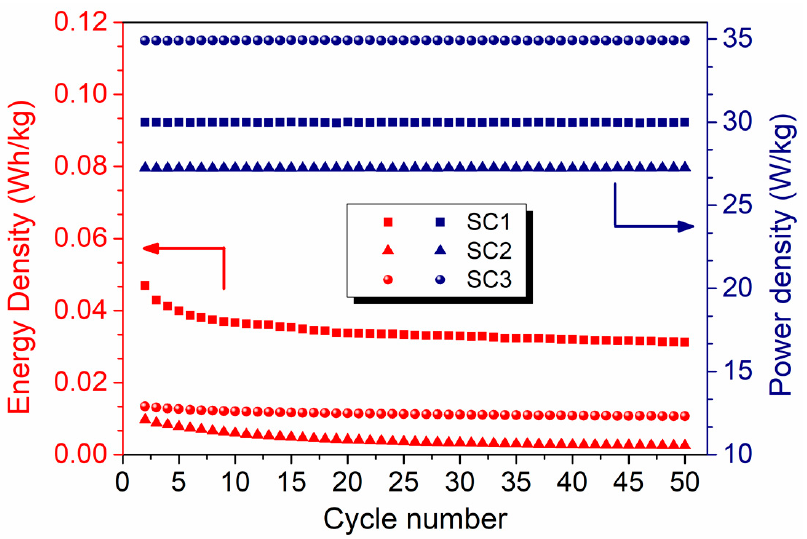
Figure 8. Comparison of the energy and power densities of the symmetric and asymmetric all-in-one SCs at a current density of 0.15 A.g − 1 .